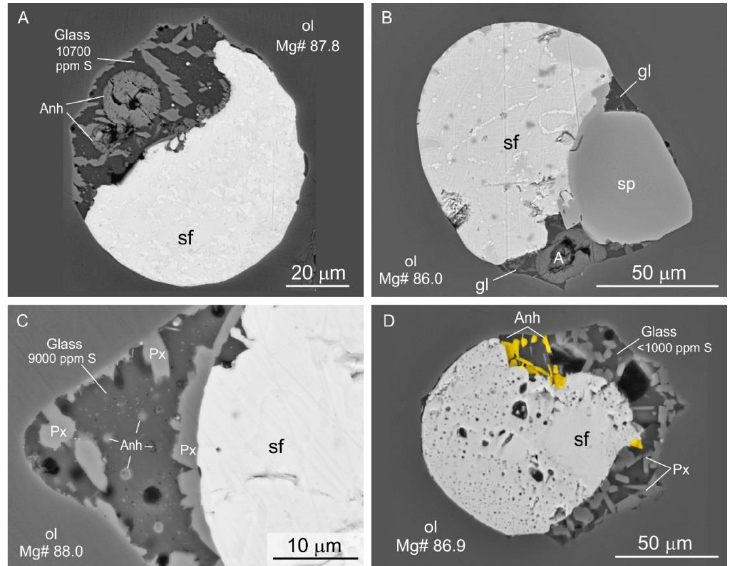
Figure 7. Back-scattered electron images outlining the morphology of anhydrite inclusions in MI. ( A ) Two spherical globules of anhydrite (~20 µ m) enclosed in S-rich glass (~1.07 wt.% S). Dendritic crystals of clinopyroxene are also present. ( B ) Deformed anhydrite globule located within a pocket of glass between a sulfide globule and spinel crystal. ( C ) Small globules of anhydrite, presumably precipitated from the cooling silicate melt, are rich in sulfur (~9000 ppm). ( D ) Anhydrite crystals in residual acid glass (64 wt.% SiO 2 ) in association with clinopyroxene; glass adjacent to anhydrite crystals is depleted in sulfur and contains no more than 1000 ppm. Anhydrite crystals are highlighted in yellow for clarity. Anh—anhydrite, px—clinopyroxene, sf—sulfide, sp—spinel, ol—olivine, and gl—glass. A, modified from